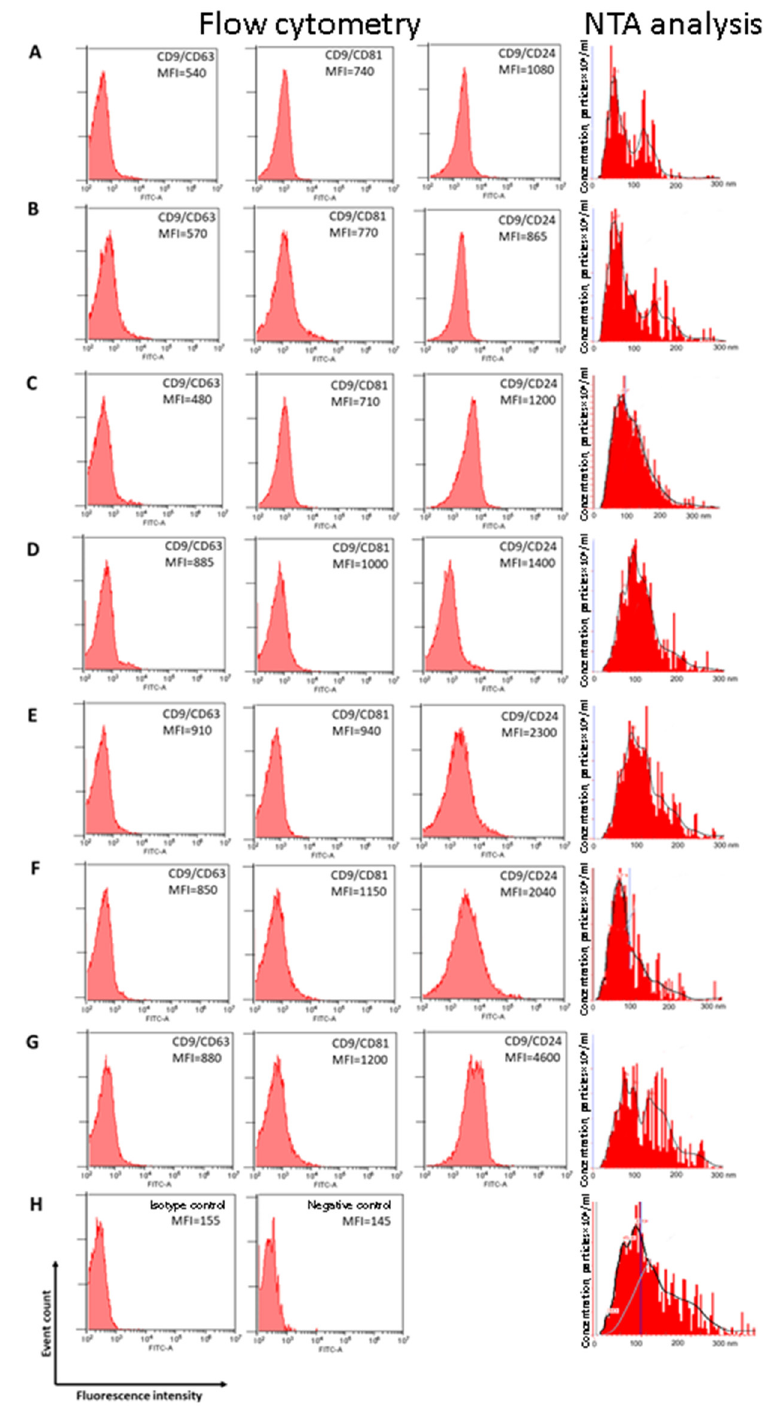
Figure 2. Exosomes characterization by flow cytometry and NTA analysis. For flow cytometry mean MFI are shown. Size distribution and expression of CD63, CD81, and CD24 on CD9-positive exosomes of ( A ) blood plasma HFs; ( B ) blood plasma of BBTPs; ( C ) blood plasma of BCPs; ( D ) blood plasma of OCPs; ( E )ascitic fluid of OCPs; ( F ) blood plasma of patient with BOTPs; ( G ) ascitic fluid of patient with BOTPs; ( H ) Isotype control (left) and negative control (right). 2.2. Proteasomal Activity and the Level of 20S Proteasome in Tissues Collectively, obtained data reveal that the extracellular vesicles isolated from blood plasma and ascites have all properties of exosomes In the study, the significant increase in chymotrypsin-like proteasomal activity (ChTL) and caspase-like (CL) proteasomal activity in malignant breast and ovarian tu- mors, was identified in comparison to the normal tissues (Table 1).